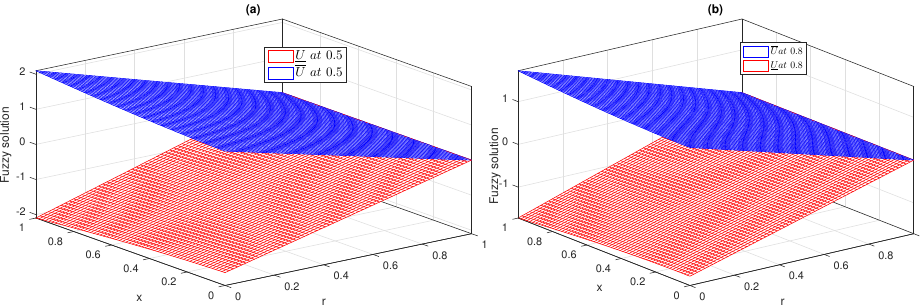
positive fuzzy solution, while k ( r ) = [ r − 1 ] , r ∈ [ 0, 1 ] provides the lower portion or negative fuzzy solution.